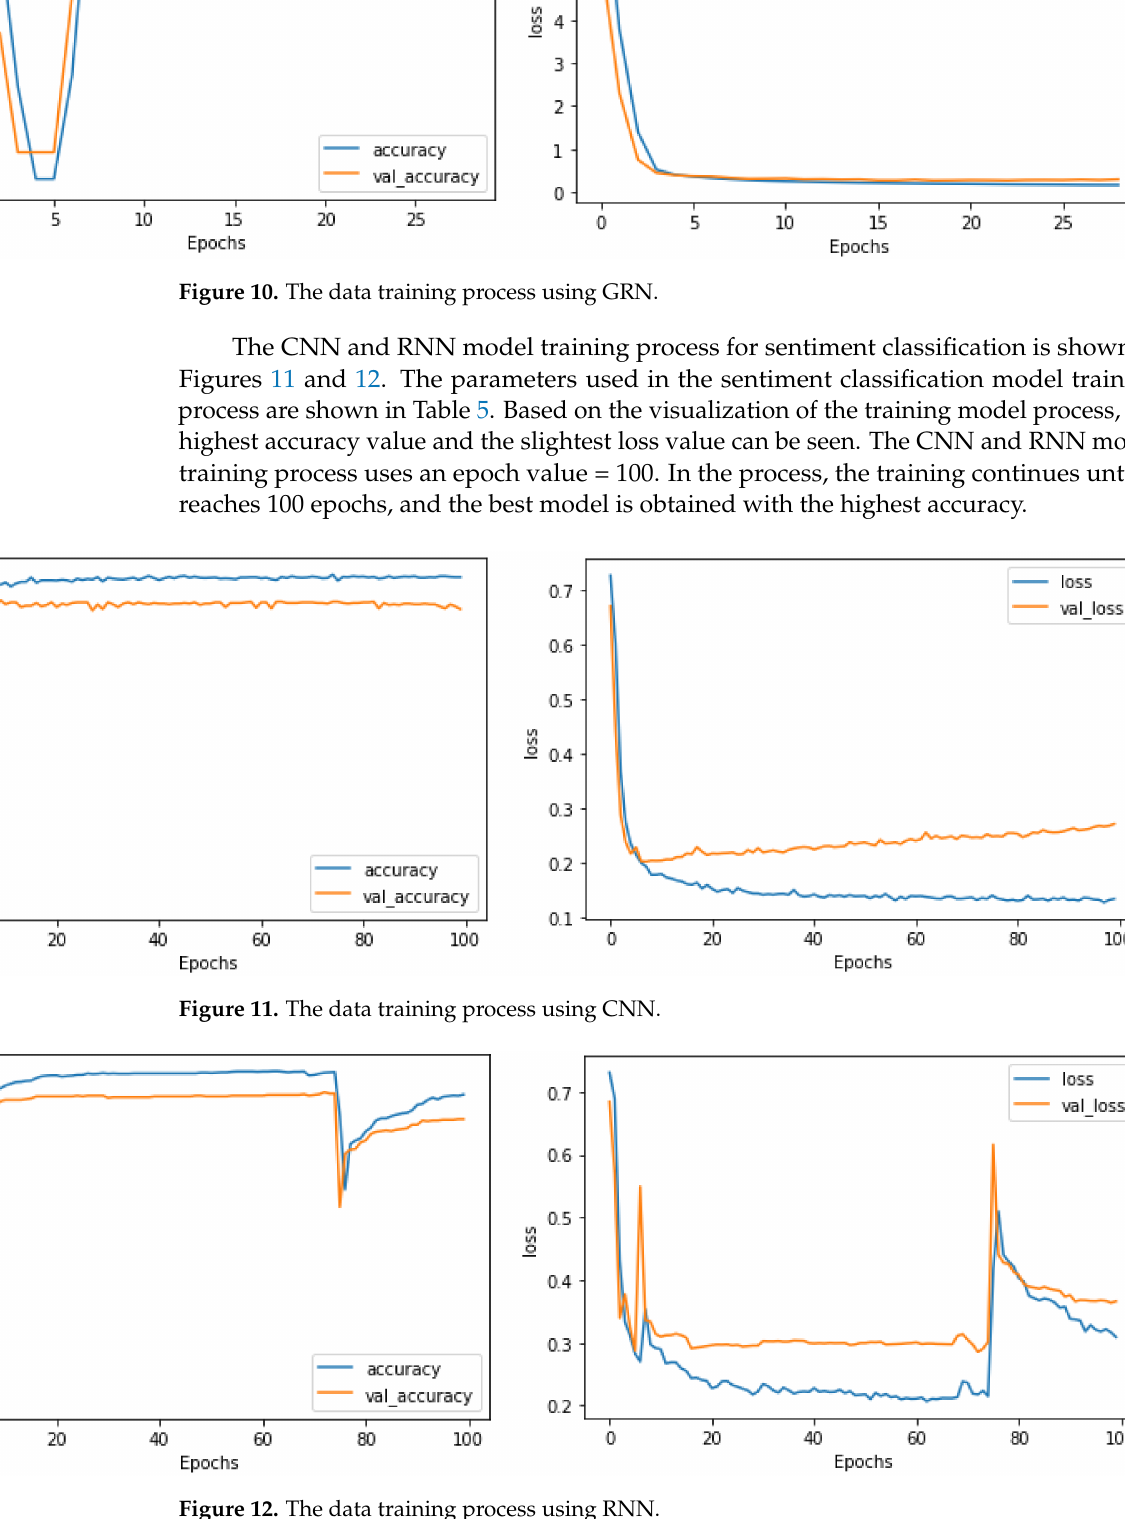
Figure 12. The data training process using